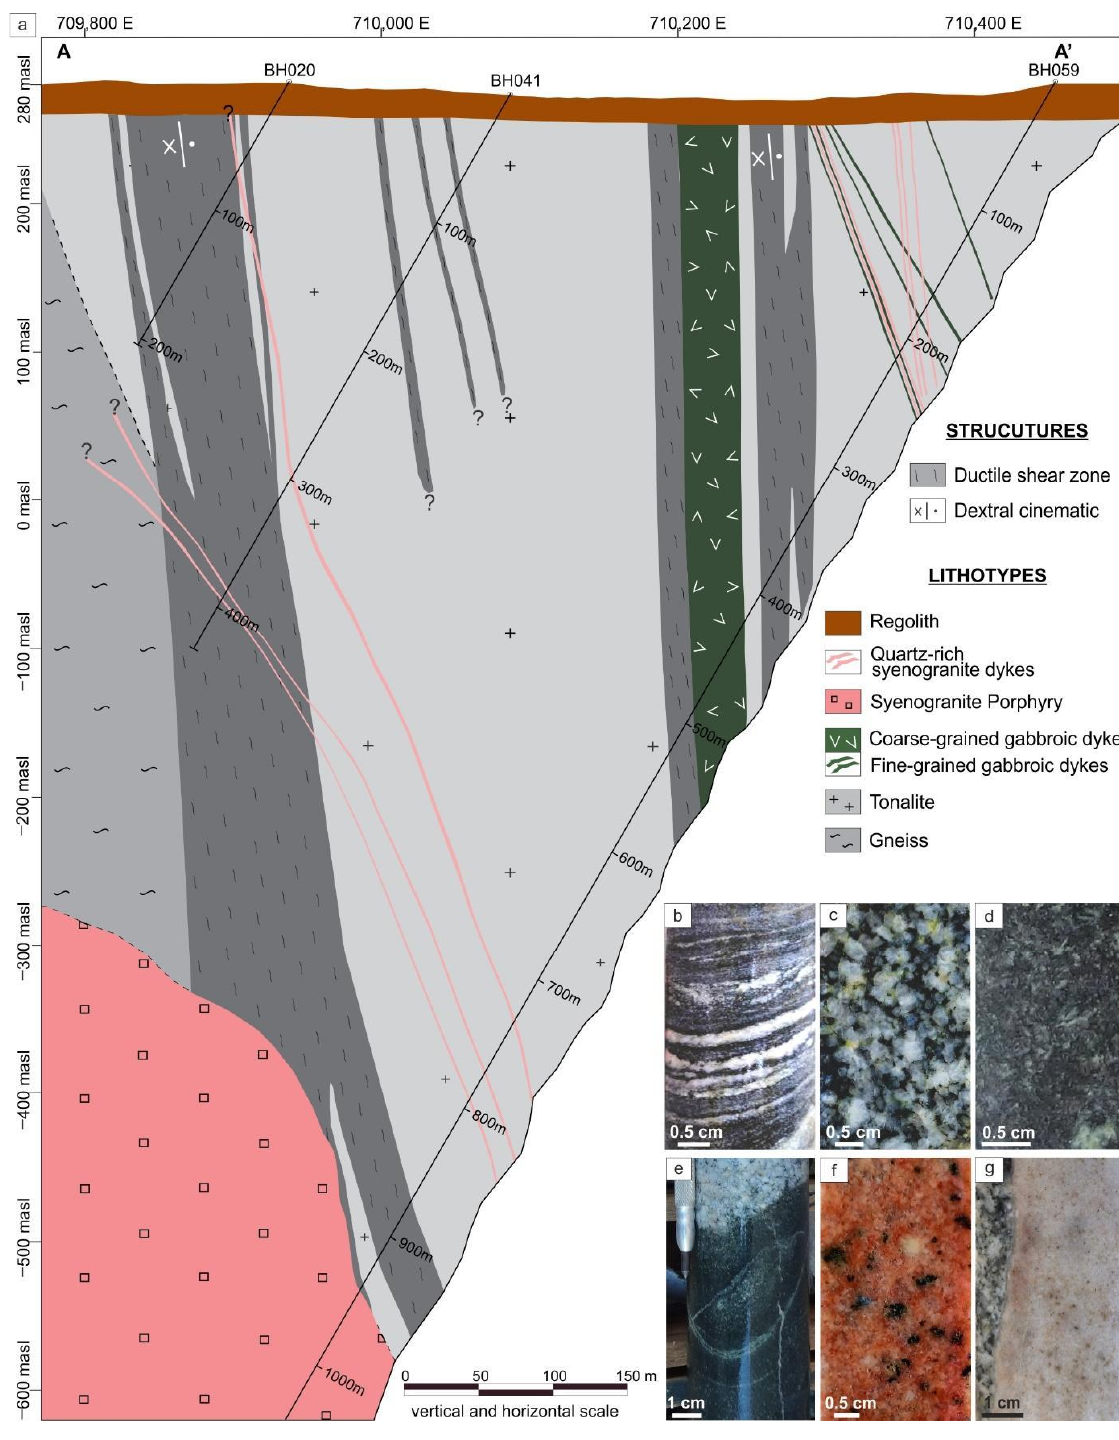
Figure 3. ( a ) Full section of the Paraíba deposit, showing temporal and spatial relationships among lithotypes. Vertical and horizontal scales are equivalent; ( b ) Paraíba biotite gneiss, with classic gneissic banding; ( c ) isotropic Paraíba biotite tonalite; ( d ) fine-grained gabbroic dyke; ( e ) fine- grained gabbroic dyke, cutting the Paraíba tonalite discordantly; ( f ) syenogranite porphyry; ( g ) quartz-rich, fine-grained, felsic syenogranite dyke cutting the Paraíba tonalite.